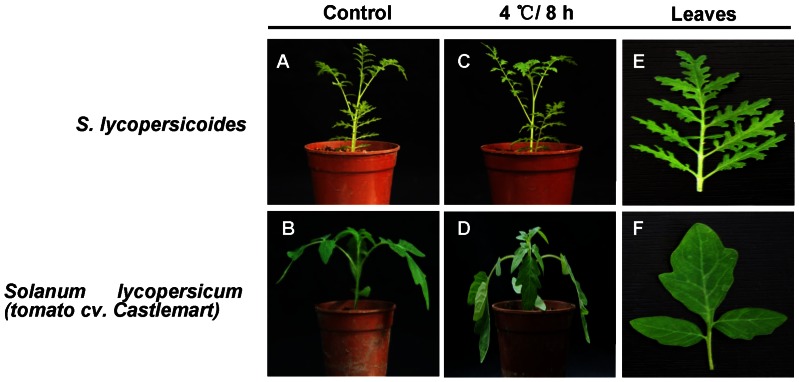
Low-temperature resistance test of S. lycopersicoides and CM.(A–D) Phenotypes of S. lycopersicoides and CM before (A, B) and after (C, D) 8 h of 4°C treatment. Seedlings of S. lycopersicoides and Solanum lycopersicum (tomato cv. Castlemart) were grown under standard conditions and transferred to a climate chamber for the low-temperature stress. (E–F) Close-up shots of S. lycopersicoides and Solanum lycopersicum (tomato cv. Castlemart) leaves.